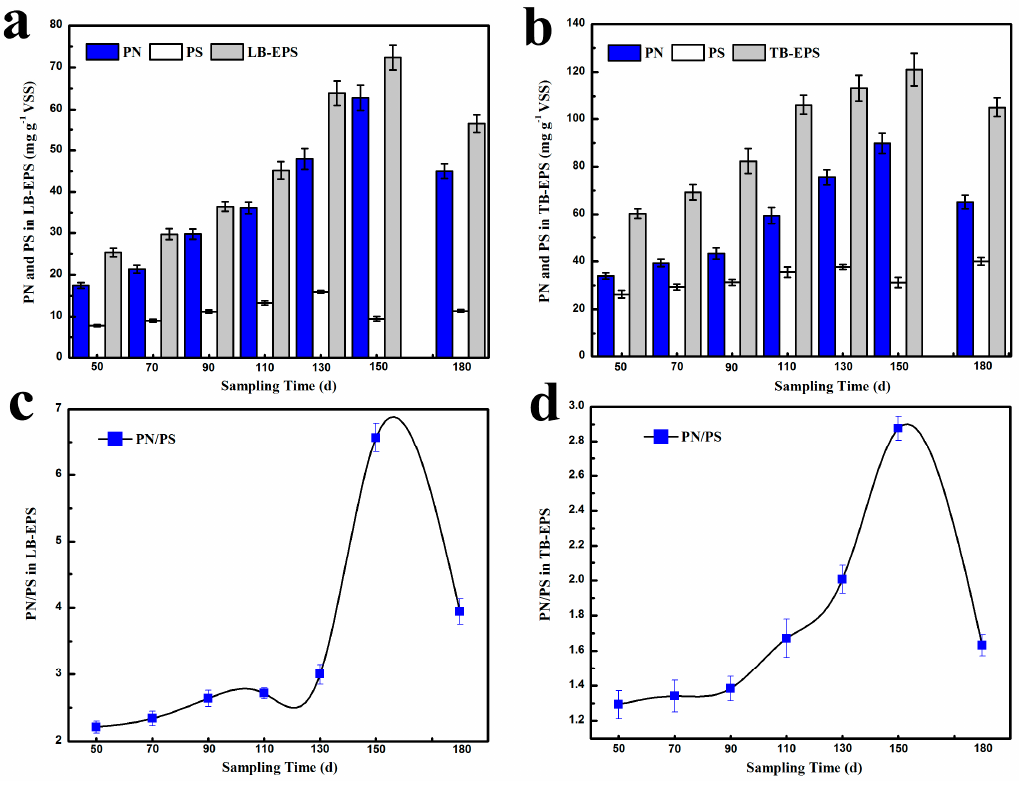
Figure 3. Variation of EPS at different Cr(VI) concentrations: PN and PS in LB-EPS ( a ) and TB-EPS ( b ) EPS content; PN/PS in LB-EPS ( c ), and TB-EPS ( d ).